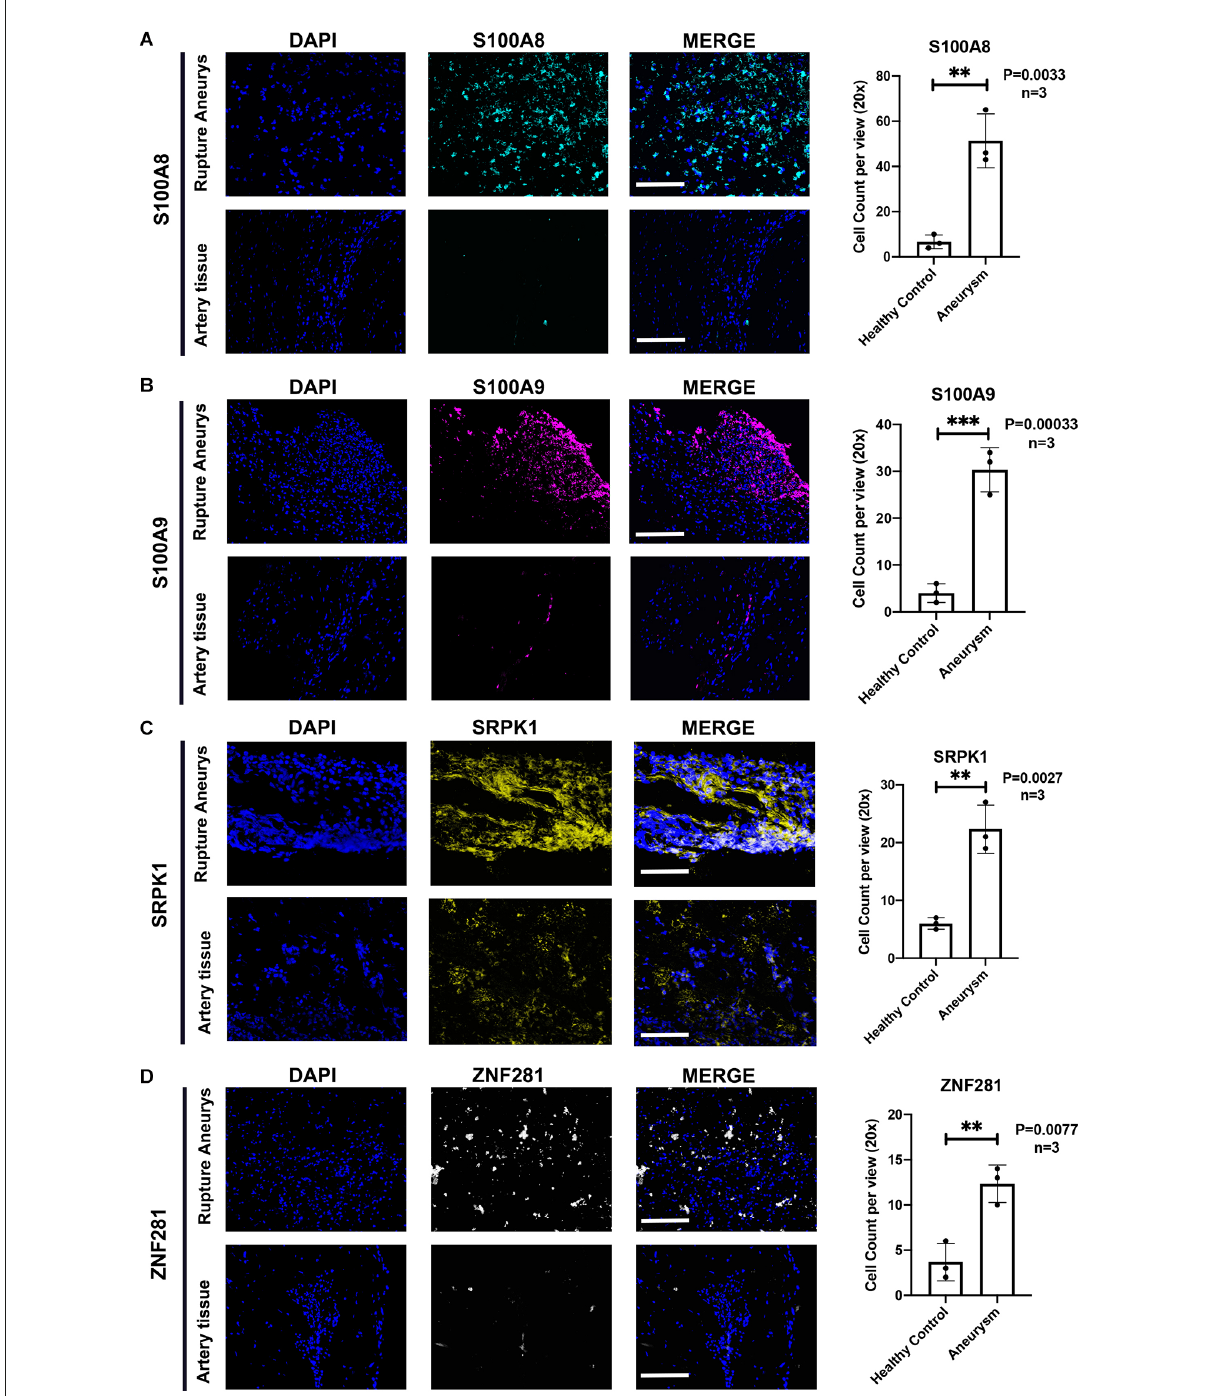
FIGURE9 (A) Representative photographs of immunofluorescence staining showing S100A8 (marked with green) and DAPI (marked with blue) in healthy group and aSAH group, and quantitative analysis of positive cells. n = 3/group; p = 0.0033. (B) Representative photographs of immunofluorescence staining showing S100A9 (marked with red) and DAPI (marked with blue) in healthy group and aSAH group, and quantitative analysis of positive cells. n = 3/group; p = 0.0003. (C) Representative photographs of immunofluorescence staining showing SRPK1 (marked with yellow) and DAPI (marked with blue) in healthy group and aSAH group, and quantitative analysis of positive cells. n = 3/group; p = 0.0027. (D) Representative photographs of immunofluorescence staining showing ZNF281 (marked with yellow) and DAPI (marked with blue) in healthy group and aSAH group, and quantitative analysis of positive cells. n = 3/group; p = 0.0077. Healthy control: Healthy Middle meningeal arteries; Aneurysm: Ruptured aneurysm tissue. Scale bar: 75 µ m ( ∗∗ p < 0.01, ∗∗∗ p <